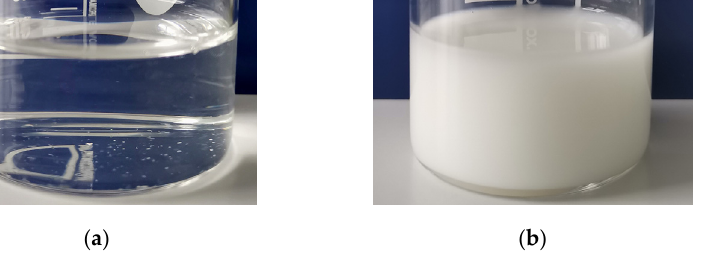
Figure 1. The visual aspect of the chitosan-based solution ( a ), fresh emulsion ( b ) and six month aged emulsion ( c ).